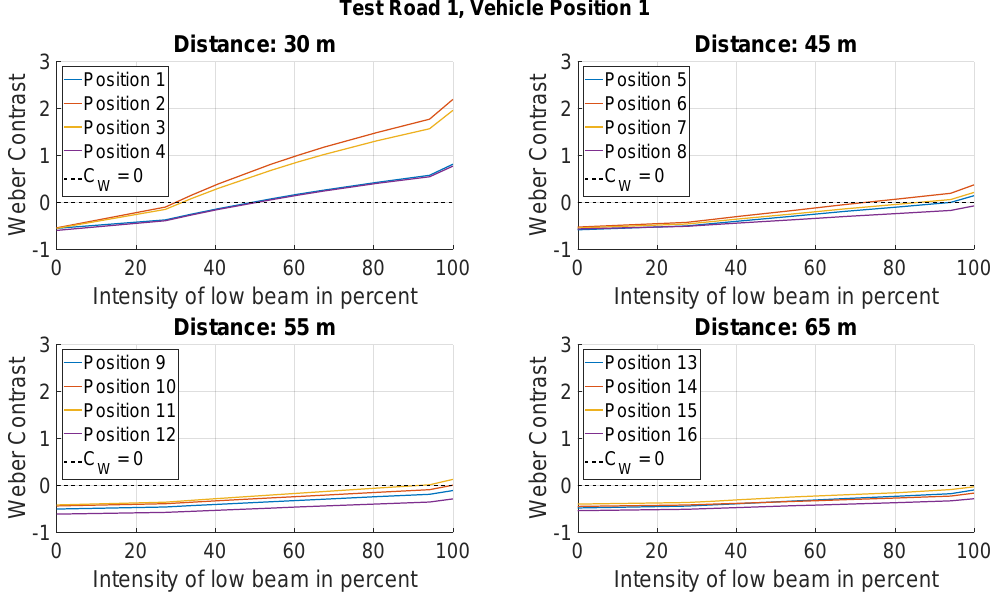
Figure 6. Contrast curves on test road 1 (0.91cdm − 2 ) and vehicle position 1 depending on the intensity percentage from 0% (low beam off) to 100% (low beam fully switched on).